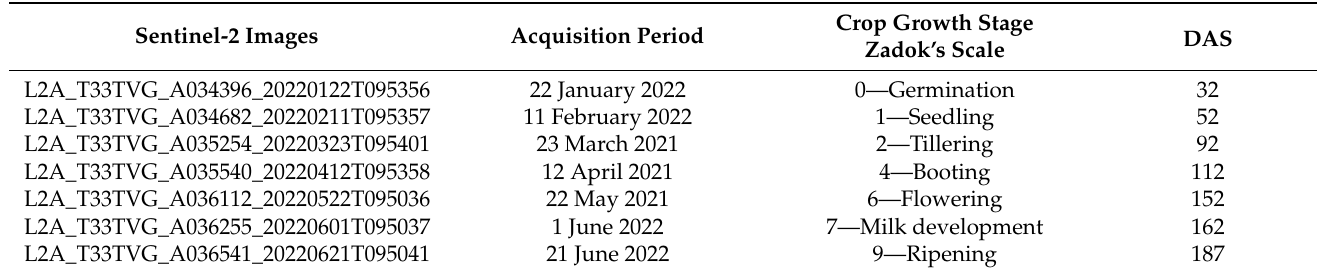
Table 1. Sentinel-2 images data acquisition period, durum wheat crop growth stage (Zadok’s scale), and day after showing